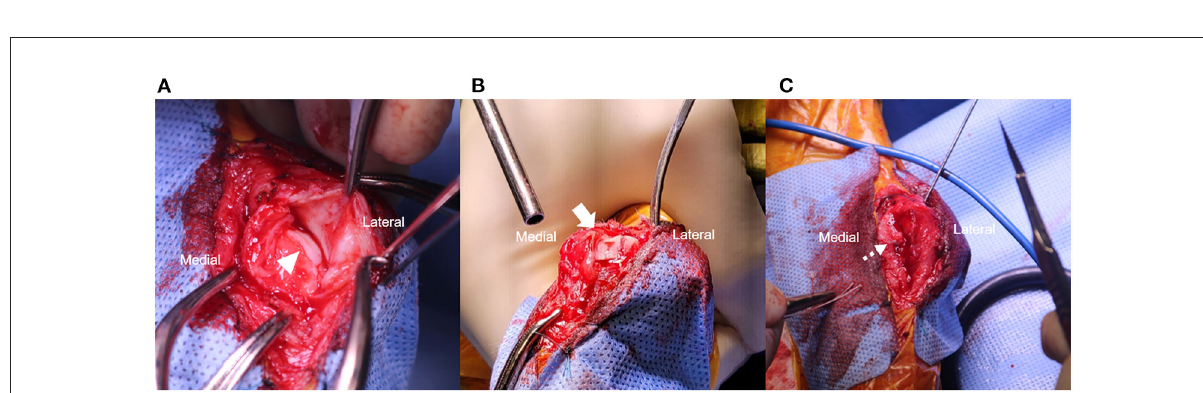
FIGURE2 Intraoperative photographs of a flattened groove of calcaneal tuber [ (A) , arrowhead]. Note the deepened depth of the calcaneal tuber following calcaneoplasty [ (B) , arrow]. Medial retinaculum was repaired using 2.4 × 8.5mm biocomposite suture anchor (SutureTak; Arthrex Inc. Naples, FL) and 2-0 non-absorbable braided suture (FiberWire; Arthrex Inc. Naples, FL) [ (C) , dotted arrow]. Temporary restraining pin was placed on the lateral aspect of calcaneal